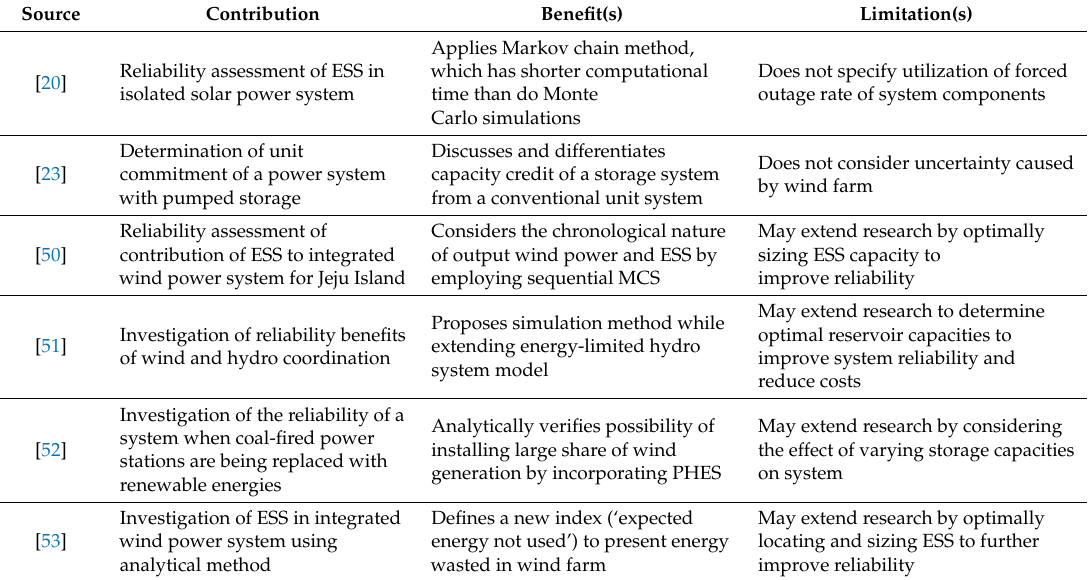
Table 6. Comparison of notable works on impacts of ESS on HL1.